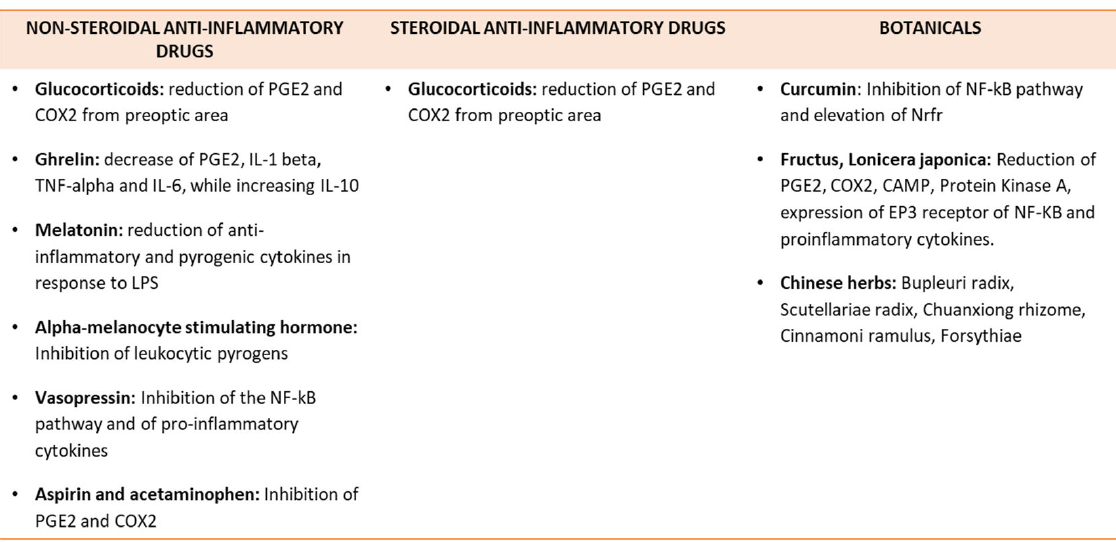
Figure 3. Major antipyretic compounds. Classical compounds and botanical e ff ects on fever are described.